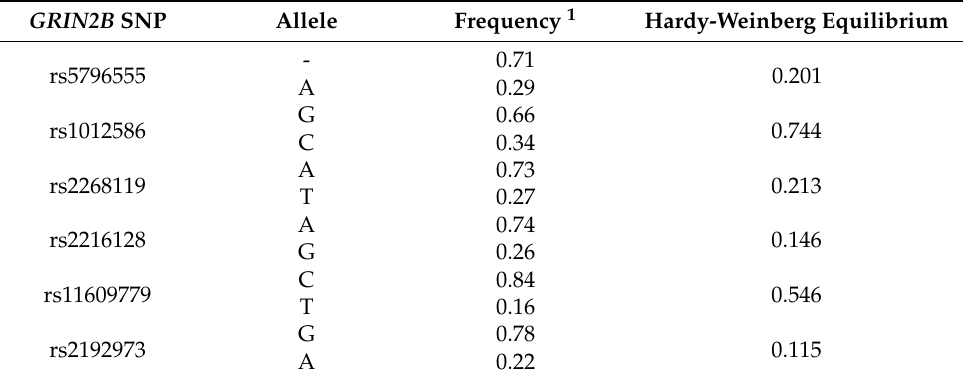
Table 2. GRIN2B allele frequencies and Hardy-Weinberg equilibrium’s p -values.